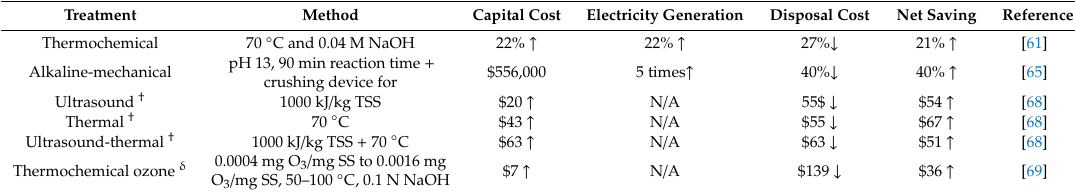
Table 4. Assessment of the cost of applying the various pretreatment methods (the vertical arrows represent our assessment of relative cost, ↑ means increase, ↓ means